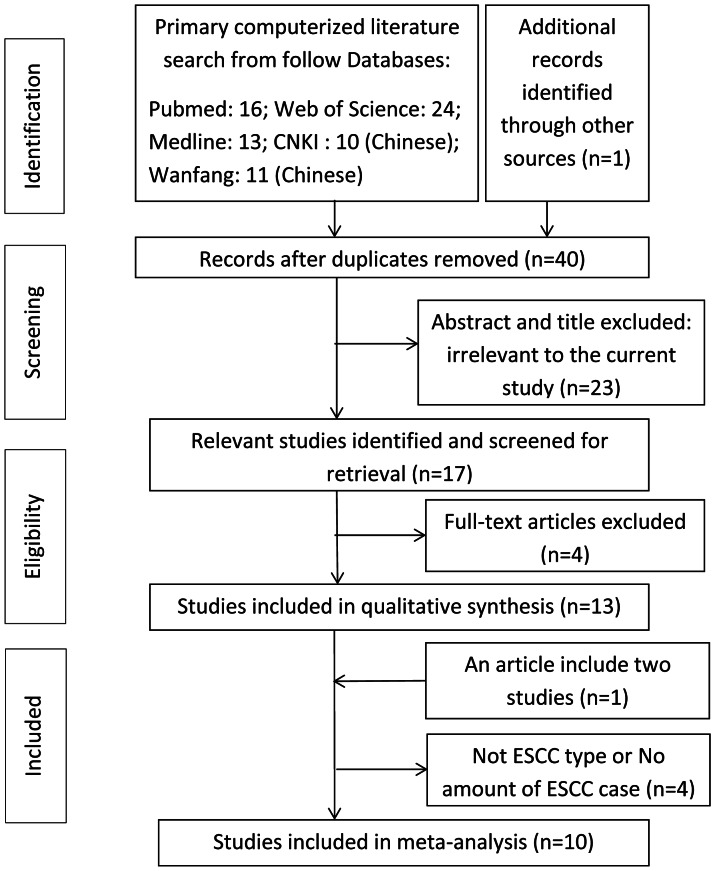
Flow diagram of the study selecting process.